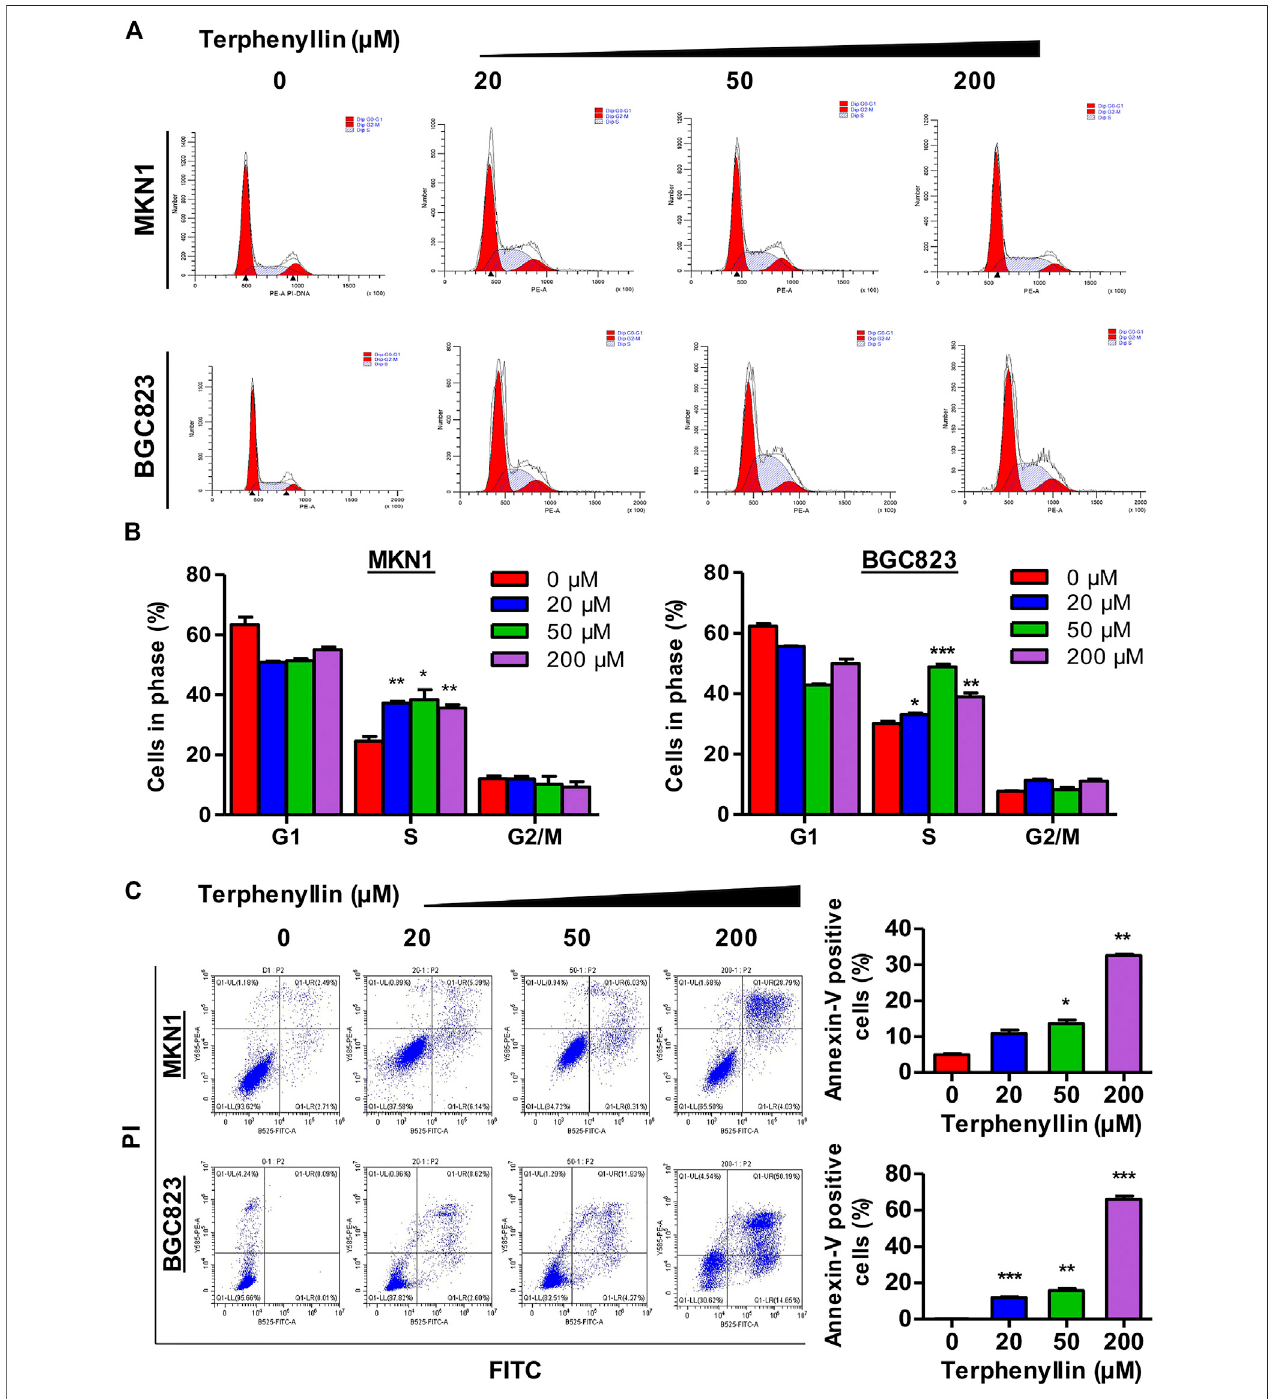
FIGURE 3 | Terphenyllin can block the cell cycle of gastric cancer and induce apoptosis in vitro. (A,B) Terphenyllin was treated for 24 h and fi xed, followed by the propidium iodide/RNase analysis. (C) MKN1 and BGC823 cells were treated with terphenyllin at the indicated concentrations for 48 h, followed by the detection of apoptosis by FITC-Annexin V assay. Results are presented as mean ± SD. ( p p < 0.05; pp p < 0.01, ppp p < 0.001).